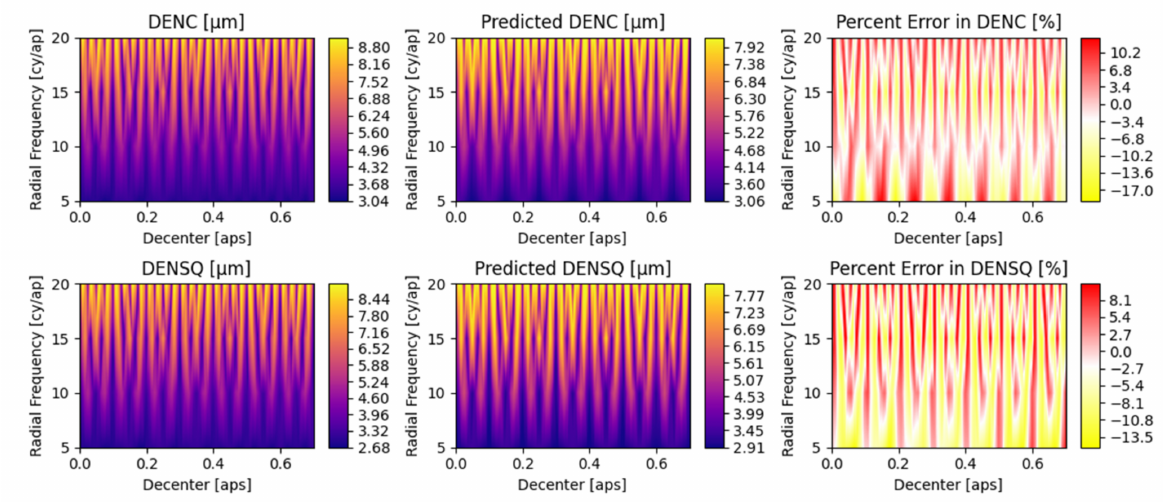
Figure A3. Decenter versus radial frequency. ( κ = ω = η = ζ = 0, σ = 0.05, θ = 30 ◦ ).